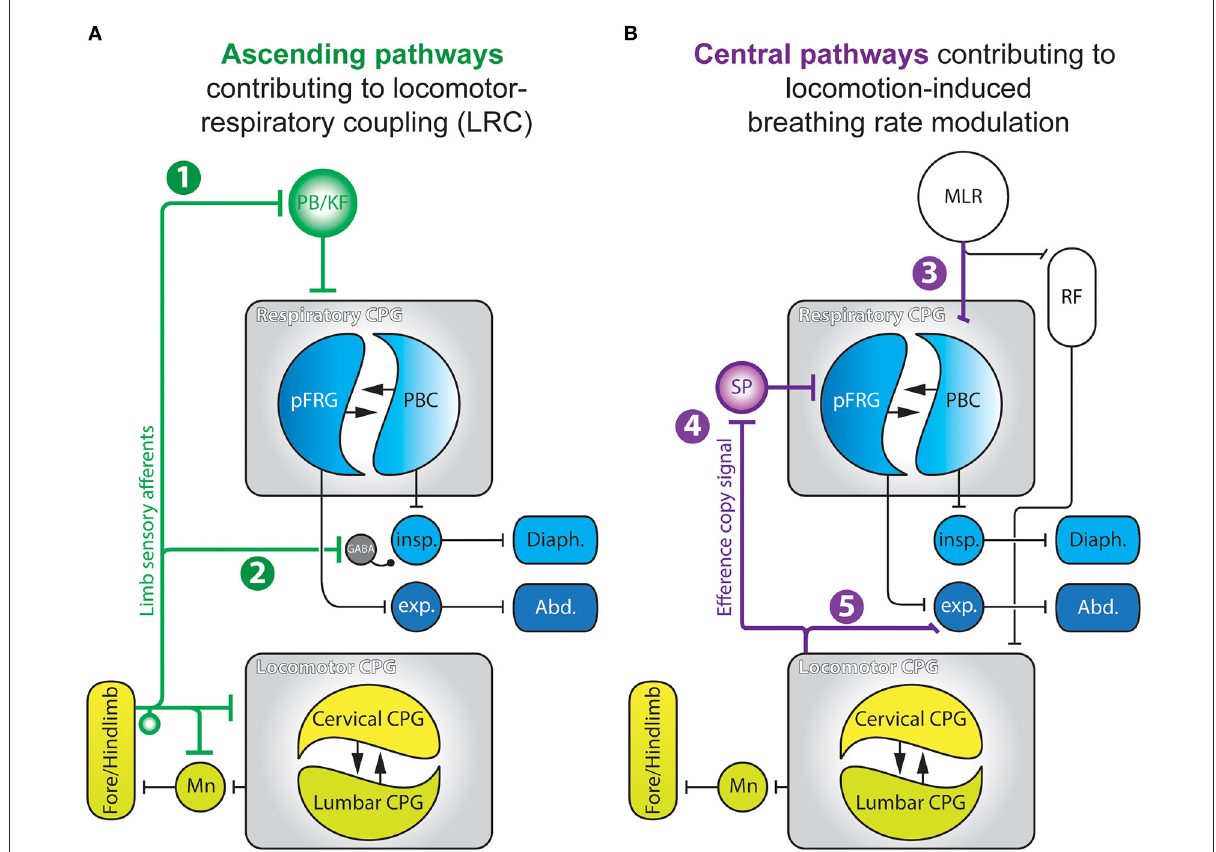
FIGURE2 Summary schematics of the neurogenic pathways contributing to locomotor-respiratory coupling (A) and locomotion-derived breathing rate modulation (B) . 1, Ascending projections from limb sensory afferents to the PB/KF complex; 2, Pathway enabling spinal proprioceptive afferents to modulate the excitability of spinal inspiratory motoneurons via a GABA-releasing relay; 3, Parallel descending drives from the MLR to the spinal locomotor CPG and to the PBC; 4, Efference copy signals conveyed by ascending glutamatergic projections from the spinal locomotor CPG to respiratory CPG networks through an SP-releasing relay; 5, Propriospinal pathway enabling the locomotor CPG to modulate activity of spinal expiratory neurons. Abd., abdominal muscles; CPG, central pattern generator; Diaph., diaphragm; exp., expiratory neurons; insp., inspiratory neurons; MLR, mesencephalic locomotor region; Mn, motoneurons; PBC, preBötzinger Complex; PB/KF, parabrachial/Kölliker-Fuse nucleus; pFRG, parafacial respiratory group; RF, reticular formation; SP, substance P. Adapted from Morin and Viala (2002), Giraudin et al.